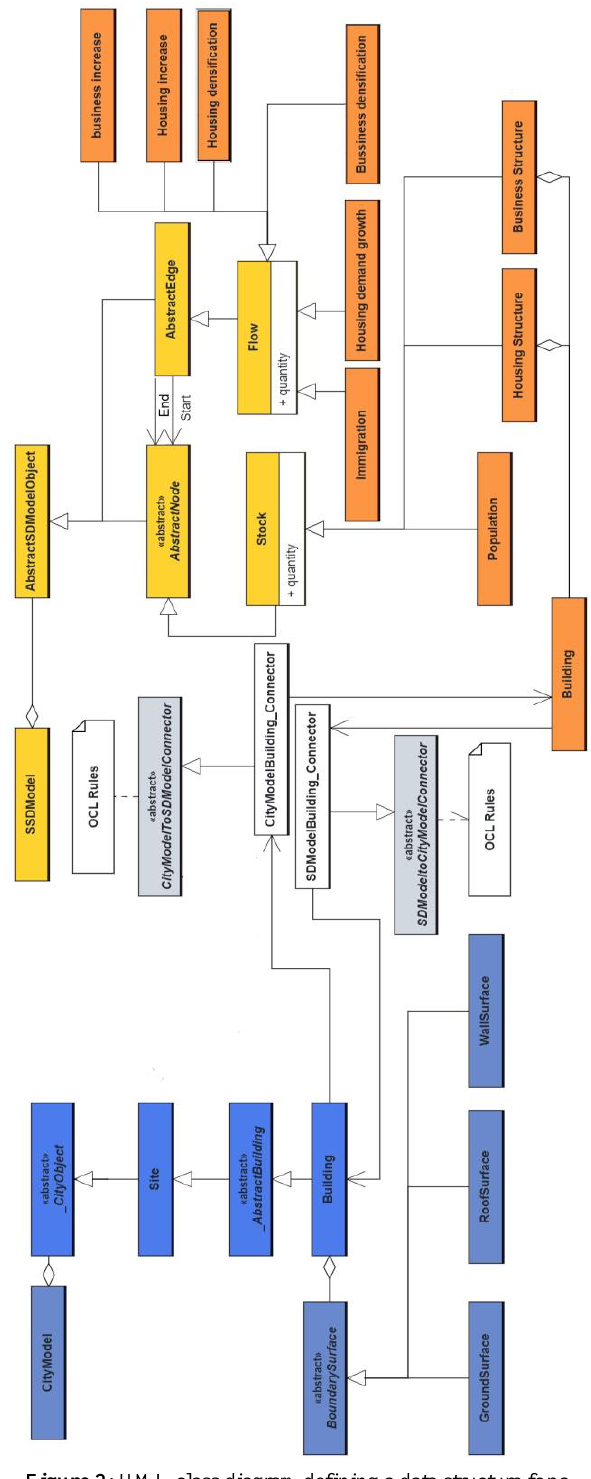
Figure 2: UML class diagram defining a data structure for a bidirectional data transfer between semantic 3D city model and SD